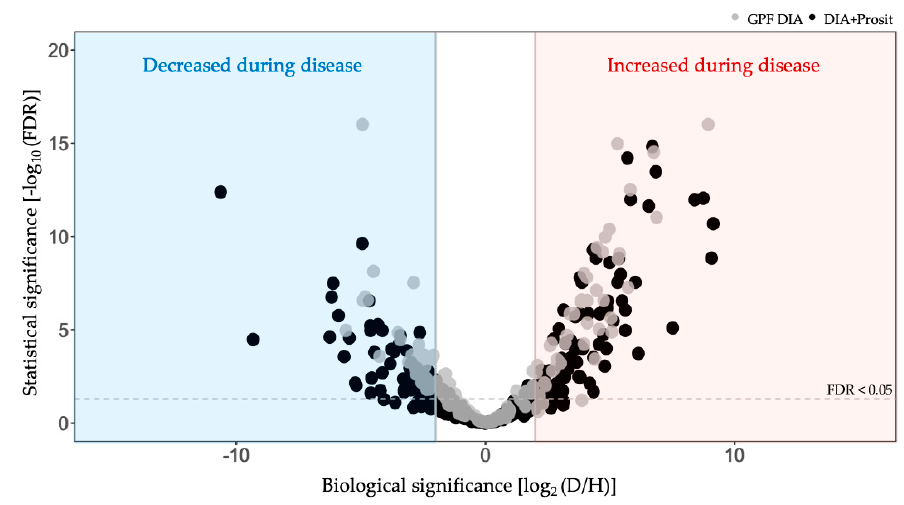
Figure 7. Proteome response of V. vinifera to Xf infection. Volcano plot analysis of vascular leaf sap obtained from diseased (D) and healthy (H) plants data identified by GPF DIA (145 proteins) and DIA+Prosit (353 proteins) overlapped. Proteins identified by GPF DIA are represented with grey dots and those identified by DIA+Prosit, with black dots. FDR calculated by Benjamin-Hochberg smaller than or equal to 0.05 were considered significant.